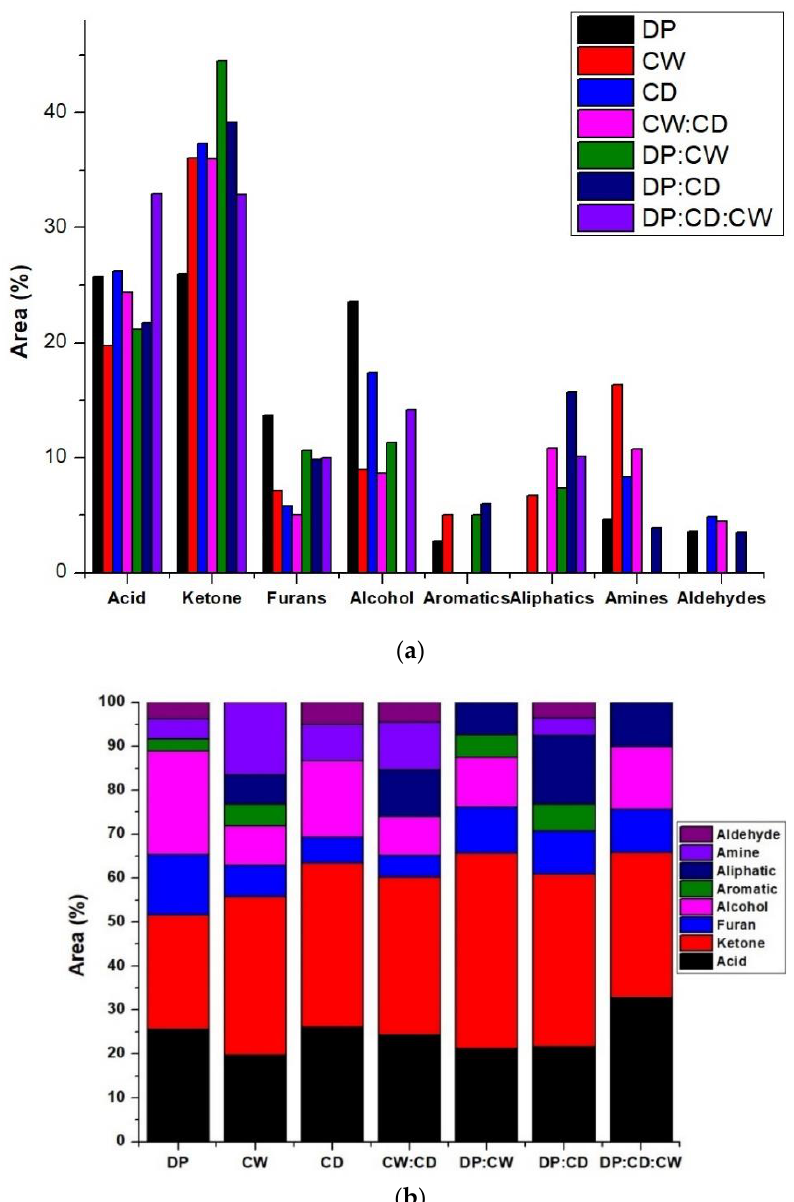
Figure 2. ( a ) Identified bio-oil component quantity in different feeds. ( b ) Ratio of bio-oil components in the